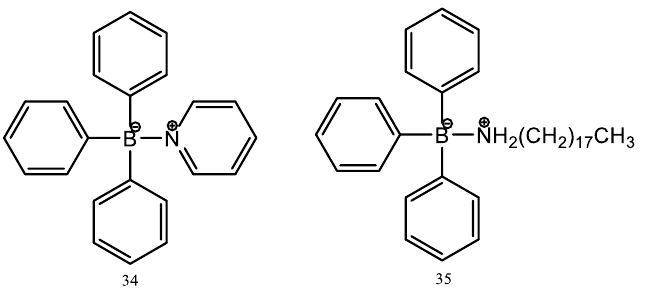
Figure 9. TPBP ( 34 ) (triphenylboranepyridine) and TPBOA ( 35 ) (triphenylboraneoctadecyl).